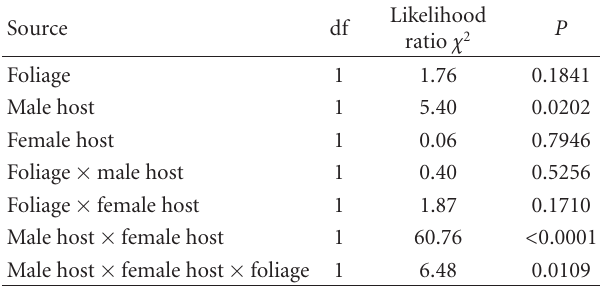
Table 3: Logistic regression analysis of sources of variation in mating preferences of male and female B. treatae assayed from no- choice mating trials. This analysis evaluates the influence of the male and female B. treatae source population and the presence versus the absence of the host plant during mating trials on the probability of mating. Foliage = present or absent; male and female host = host plant species from which each sex was collected ( Q. geminata or Q. virginiana